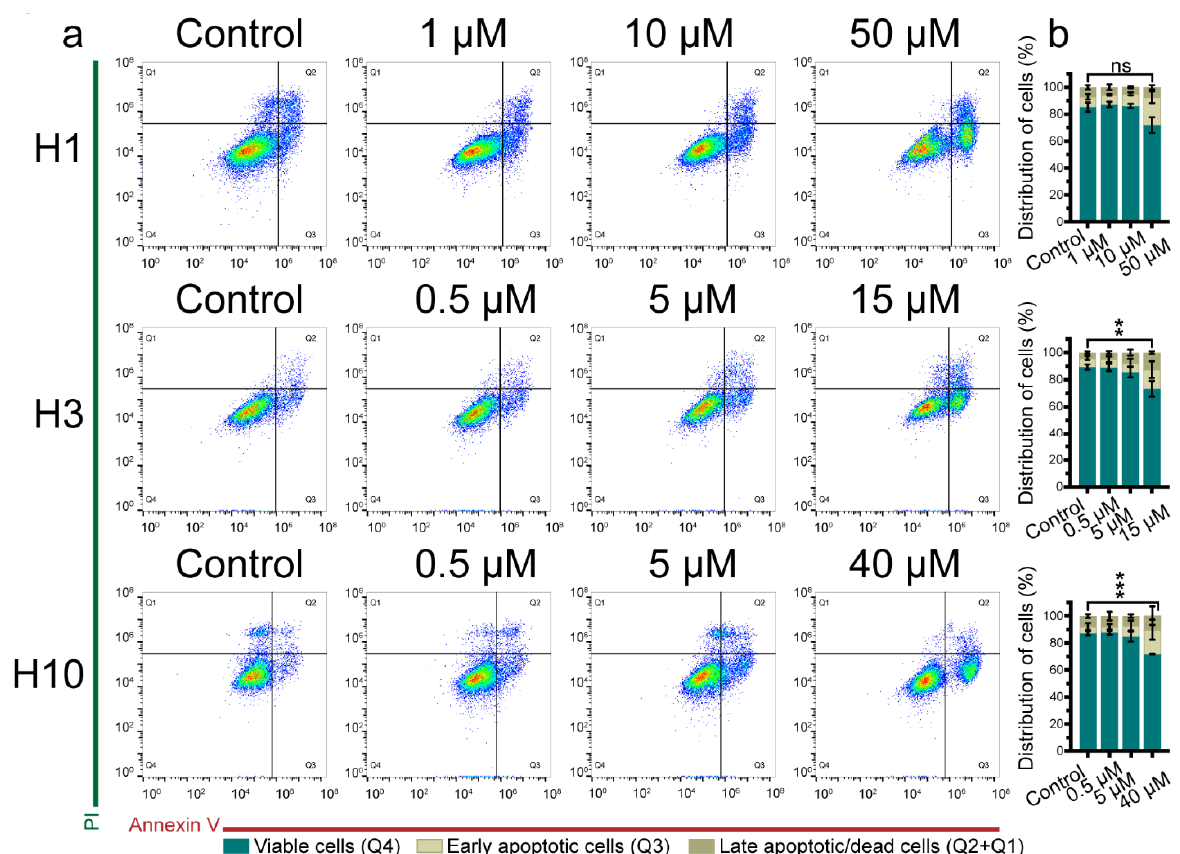
Figure 4. Cabozantinib induces apoptosis in MBM cell lines. ( a ) Representative dot plots of cells untreated (control) or treated with different doses of cabozantinib as indicated for 72 h. Annexin V labels apoptotic cells and propidium iodide (PI) labels necrotic cells. ( b ) Quantification of the percentage of viable, apoptotic and necrotic cells in H1, H3 and H10 cell cultures as untreated (control) or after exposure to cabozantinib. The experiments were performed in triplicate. Q1: necrotic cells; Q2: late apoptotic cells; Q3: early apoptotic cells; Q4: viable cells; ns: not significant; **: p < 0.01 in late apoptotic cells between the control and cells treated with the highest drug dose; ***: p < 0.001 in viable cells between the control and cells treated with the highest drug dose.